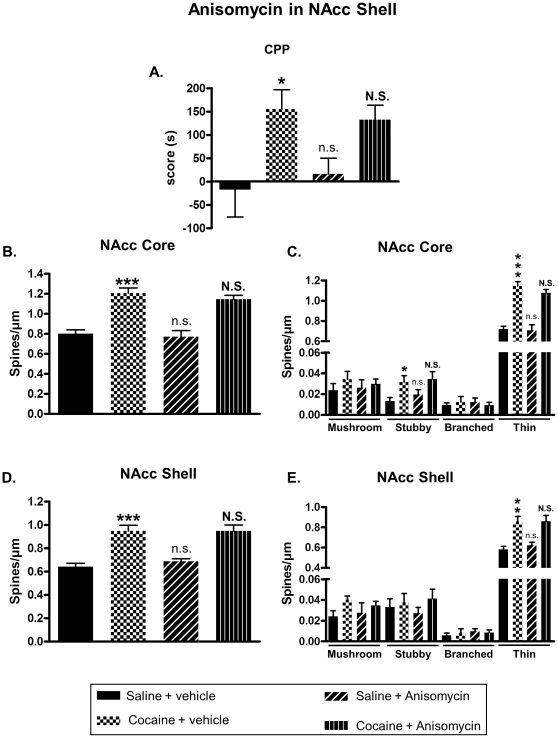
Anisomycin injection in the shell immediately after cocaine conditioning is devoid of any effects on CPP and neuroplasticity in the NAcc core and shell.CPP was induced in adult rats with saline or cocaine at 20 mg/kg. After each afternoon conditioning session, rats received intra-shell infusion of anisomycin or vehicle. Immediately after the test, brains were processed for DeS analysis. CPP scores were expressed as the means ± S.E.M. (A) (Two-way ANOVA, Fcocaine(1,32) = 10.68, p<0.01; Fanisomycin(1,32) = 0.01307, p = 0.909; Fcocaine × anisomycin = 0.4087, p = 0.527). Total DeS density was expressed as spines/µm (mean ± S.E.M.) in MSN from the NAcc core (B) (Two-way ANOVA, Fcocaine(1,32) = 61.75, p<0.001; Fanisomycin(1,32) = 0.8887, p = 0.352; Fcocaine × anisomycin = 0.1014, p = 0.752) and shell (D) (Two-way ANOVA, Fcocaine(1,32) = 52.96, p<0.001; Fanisomycin(1,32) = 0.3396, p = 0.564; Fcocaine × anisomycin = 0.3232, p = 0.573). Density of mushroom, stubby, branched or thin spines was expressed as spines/µm (mean ± S.E.M.) in MSN from the NAcc core (C) (Two-way ANOVA mushroom, Fcocaine(1,32) = 1.098, p = 0.302; Fanisomycin(1,32) = 0.024, p = 0.877; Fcocaine × anisomycin = 0.247, p = 0.621; Two-way ANOVA stubby, Fcocaine(1,32) = 8.046, p<0.01; Fanisomycin(1,32) = 0.646, p = 0.427; Fcocaine × anisomycin = 0.08, p = 0.778; Two-way ANOVA branched, Fcocaine(1,32) = 0.005, p = 0.942; Fanisomycin(1,32) = 0.005, p = 0.939; Fcocaine × anisomycin = 0.666, p = 0.42; Two-way ANOVA thin, Fcocaine(1,32) = 82.94, p<0.001; Fanisomycin(1,32) = 0.779, p = 0.384; Fcocaine × anisomycin = 0.369, p = 0.547) and shell (E) (Two-way ANOVA mushroom, Fcocaine(1,32) = 3.143, p = 0.085; Fanisomycin(1,32) = 0.03, p = 0.862; Fcocaine × anisomycin = 0.484, p = 0.491; Two-way ANOVA stubby, Fcocaine(1,32) = 1.353, p = 0.253; Fanisomycin(1,32) = 0.019, p = 0.891; Fcocaine × anisomycin = 0.382, p = 0.54; Two-way ANOVA branched, Fcocaine(1,32) = 0.04, p = 0.841; Fanisomycin(1,32) = 0.544, p = 0.465; Fcocaine × anisomycin = 0.419, p = 0.521; Two-way ANOVA thin, Fcocaine(1,32) = 34.31, p<0.001; Fanisomycin(1,32) = 0.233, p = 0.632; Fcocaine × anisomycin = 0.206, p = 0.653).* p<0.05; ** p<0.01; *** p<0.001; n.s. (not significant) vs Saline + veh group. N.S. (not significant) vs Coc + veh, Bonferroni post-hoc test, n = 7 to 10 animals/group.